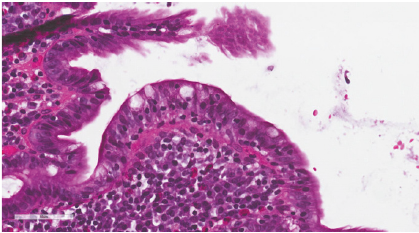
Figure 3: Higher power view highlighting a marked increase in intraepithelial